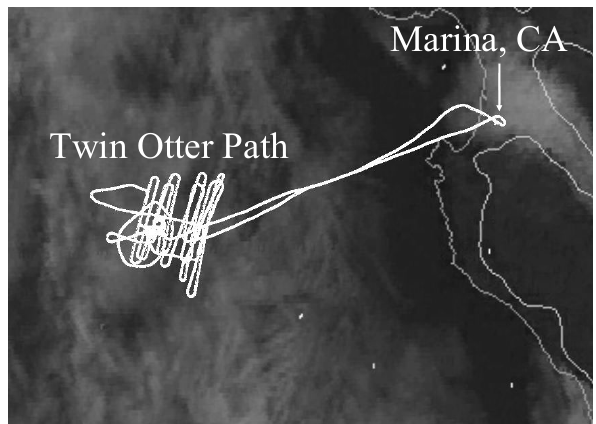
Fig. 7. GOES-11 visible satellite imagery at 18:00UTC on 16 July 2011 with the superposition of the CIRPAS Twin Otter, which was based in Marina, California. The high density of flight track points to the far west coincides with when the aircraft was probing the smoke plume generated by the R/V Point Sur ship. The corresponding time series of aircraft data is shown in Fig. 8 with aerosol size distribution and composition data shown in Fig.